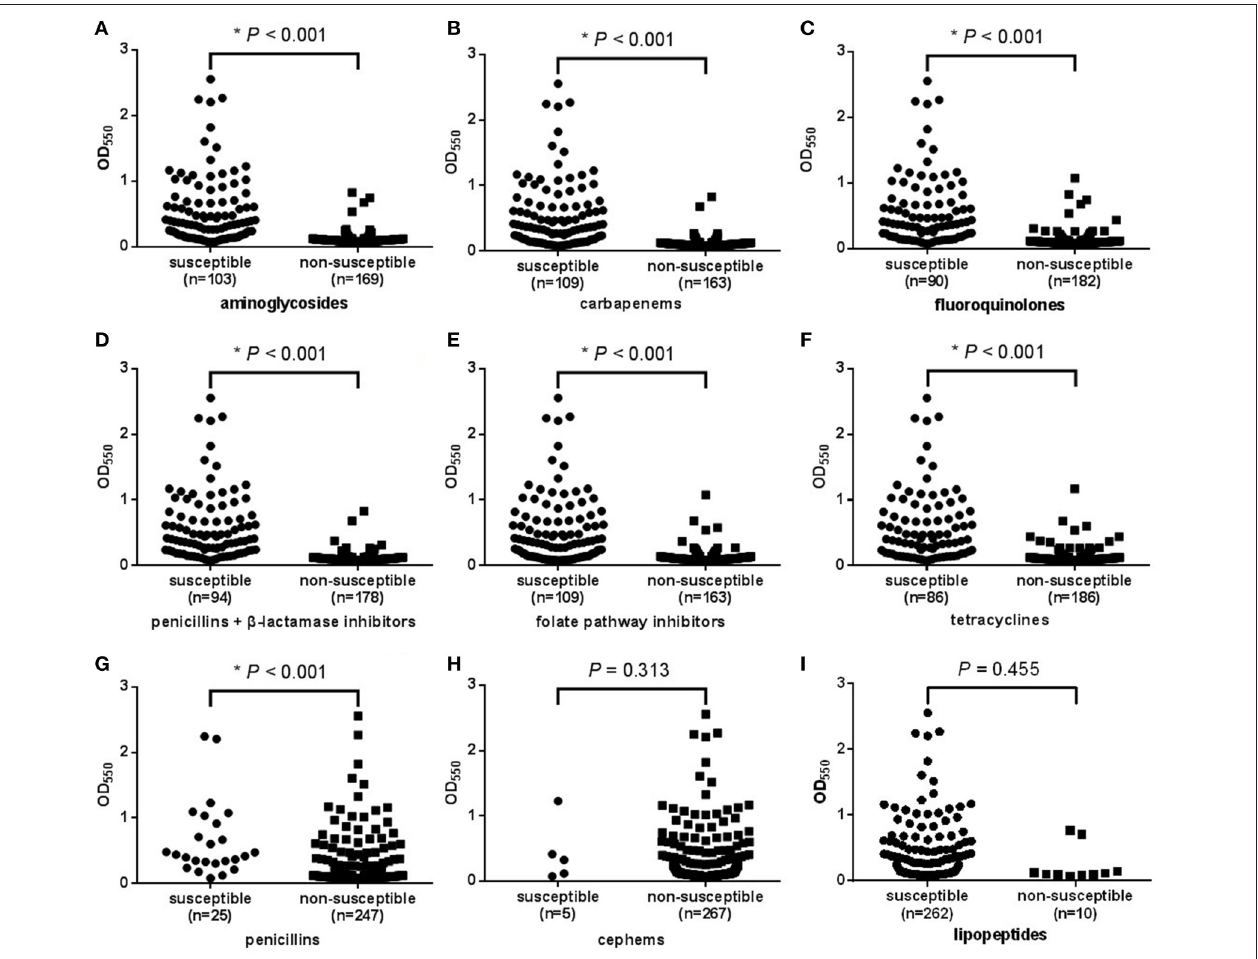
FIGURE 3 | Relationship between biofilm formation and the resistance of A. baumannii isolates to each of the nine antimicrobial categories. OD 550 , optical density at 550 nm, represents biofilm forming capacity. (A–G) : For aminoglycosides, carbapenems, fluoroquinolones, penicillins + β -lactamase inhibitors, folate pathway inhibitors, tetracyclines, and penicillins, susceptible isolates tended to form stronger biofilms (higher OD 550 values) than non-susceptible ones. (H,I) : For cephems and lipopeptides, no significant difference in biofilm formation among susceptible and non-susceptible isolates was